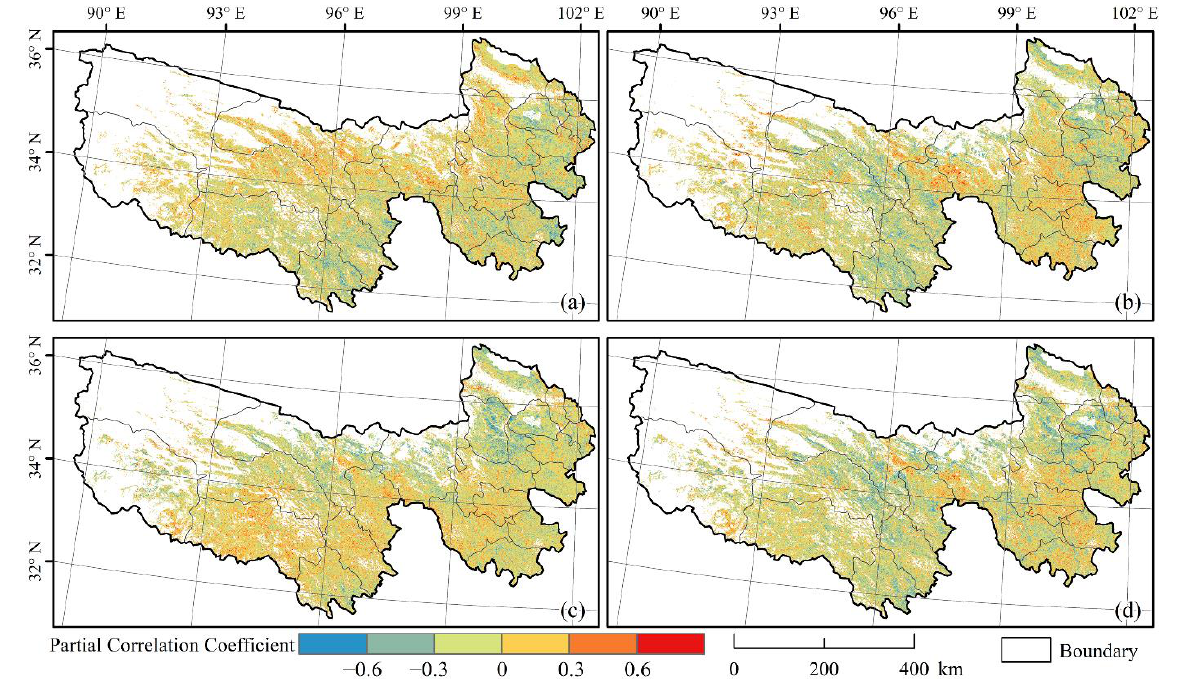
Figure 10. Spatial distribution of the partial correlation coefficients between the SOS of the vegetation and precipitation in March ( a ), April ( b ), May ( c ) and March – May ( d ) in the Three-River headwaters region.